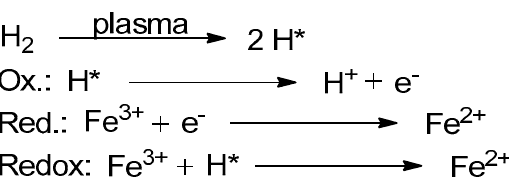
Figure 16. Redox equations of the elemental processes during the plasma reduction of the iron salt layers with the specific oxidation and reduction equations in the second and third line. The first line shows the plasma-induced dissociation of molecular hydrogen to excited atomic hydrogen (H*) and the last stands for the complete redox process.